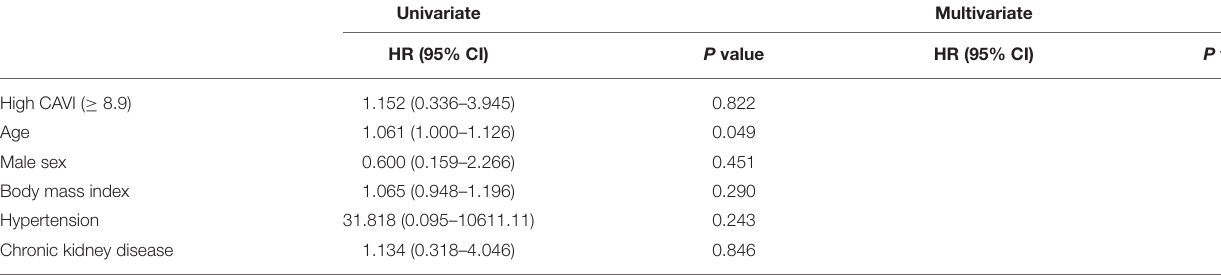
TABLE 4 | Cox proportional hazard model for ischemic coronary events.